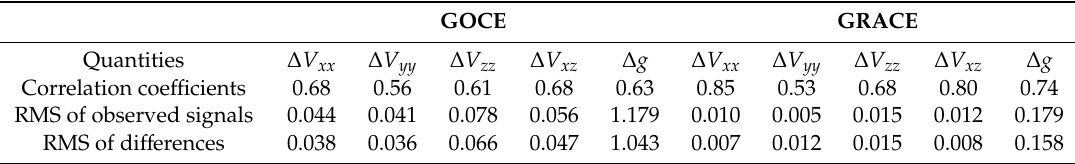
Table 2. Correlation coe ffi cients, RMS of observed gravity and gravity gradients ( ∆ V xx , ∆ V yy , ∆ V zz , ∆ V ∆ g), RMS of the di ff erences between the observed and forward modeling signals. The observed xz and signals are from GRACE and GOCE. The positions for the computation are located in the region of 28 ◦ N–48 ◦ N, 132 ◦ E–152 ◦ E. The unit of ∆ V xx , ∆ V yy , ∆ V zz , and ∆ V xz is mE and the unit of ∆ g is µ Gal. GOCE GRACE Quantities ∆ V xx ∆ V yy ∆ V